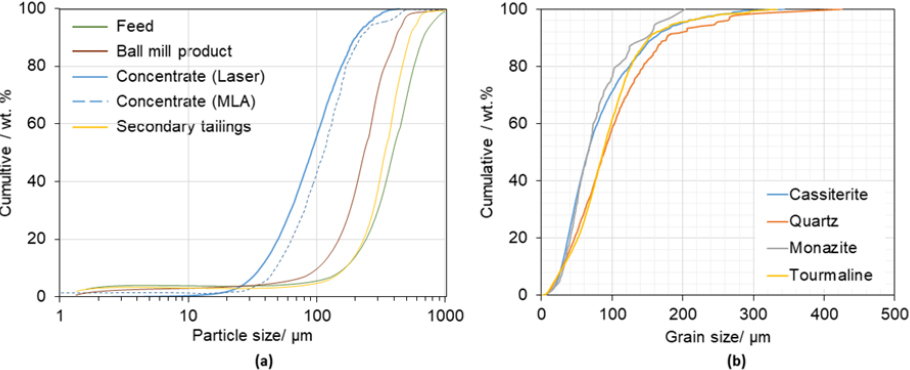
Figure 7. ( a ) Particle size of feed, concentrate and tailings from the Catavi plant, ( b ) Grain size of the minerals from the concentrate.